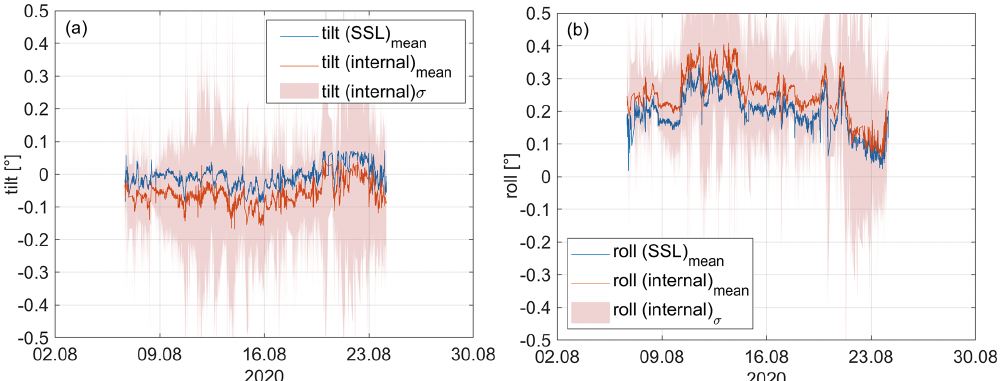
Figure 6. (a) Lidar tilt from internal inclinometer (internal, red) and from SSL (blue). The red band shows the standard deviation (SD) of the inclinometer tilt during each SSL scan. (b) Lidar roll from internal inclinometer (internal, red) and from SSL (blue). The red band shows the standard deviation ( σ ) of the inclinometer roll during each SSL